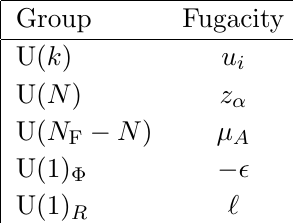
Table 2 . Holonomies and Fugacities of the